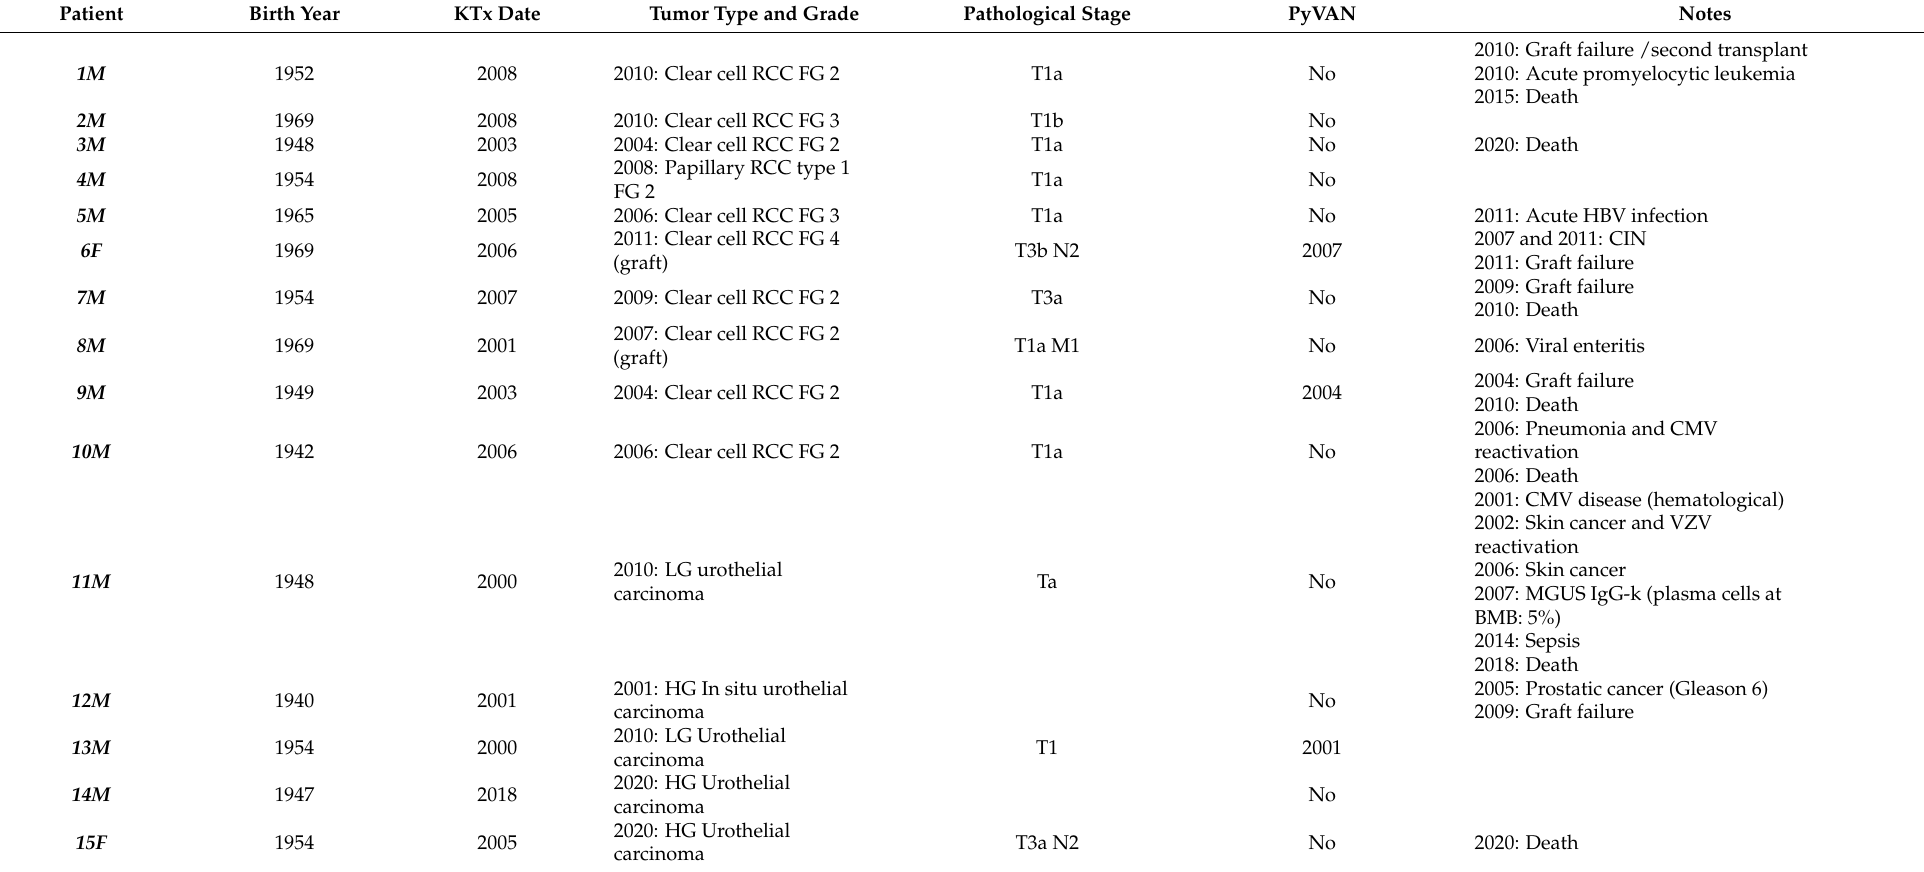
Table 1. Clinical history of patients developing kidney and urinary tract